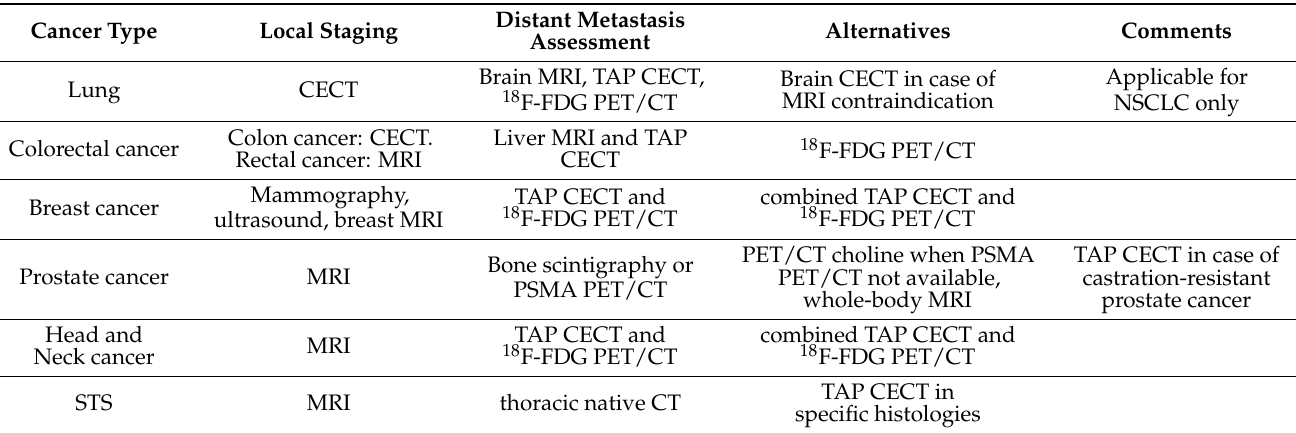
Table 1. Imaging recommendations for oligometastasis